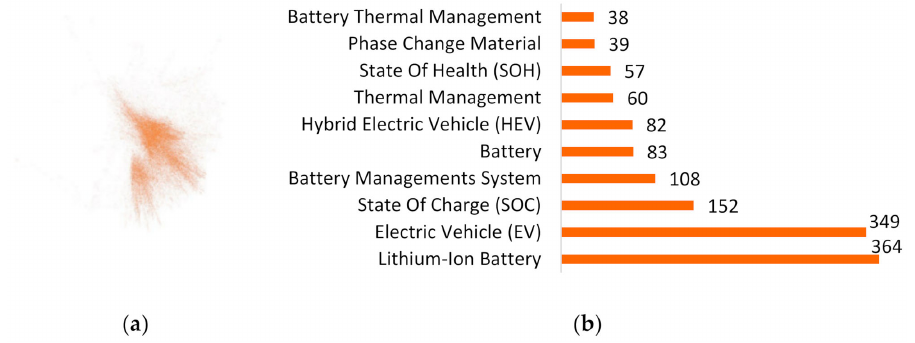
Figure 8. Representation of the EV Battery Management community: ( a ) isolated distribution of publications; ( b )